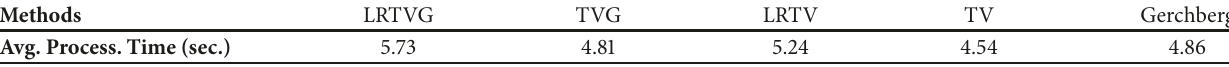
Table 2: The average processing times for one iteration. The image size was 220 × 220 × 220 .